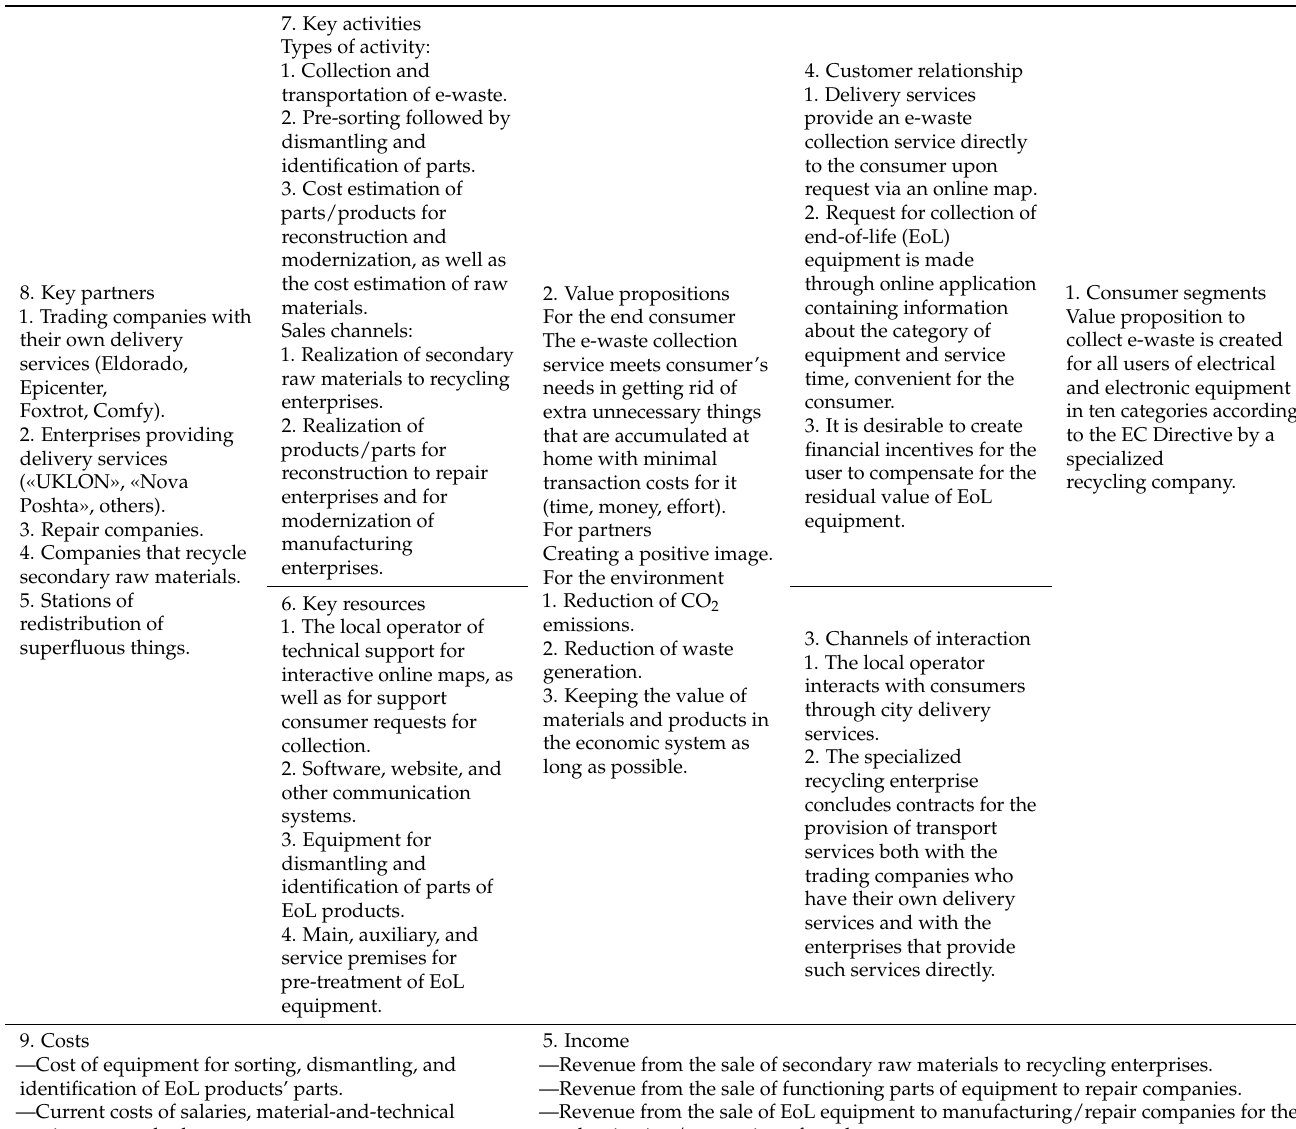
Table 1. Business model canvas (BMC) of the smart e-waste reverse